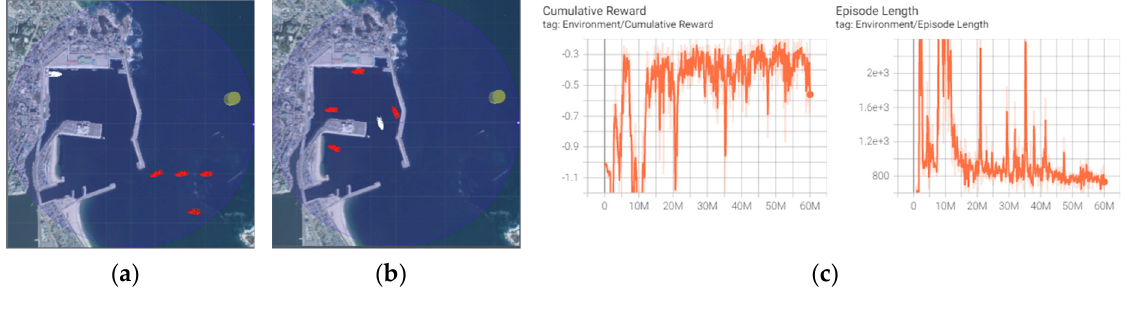
Figure 7. ( a ) Randomly generated neighboring ships starting to enter into the harbors. ( b ) Autonomous ship having lots of acceleration and deceleration controls to avoid the risk ar- eas. ( c ) Learning results expressed with rewards and episode length. Convergence of learning from approximately 25 million steps, stabilizing after 60 million steps (approximately one learning scenario = No. of learning